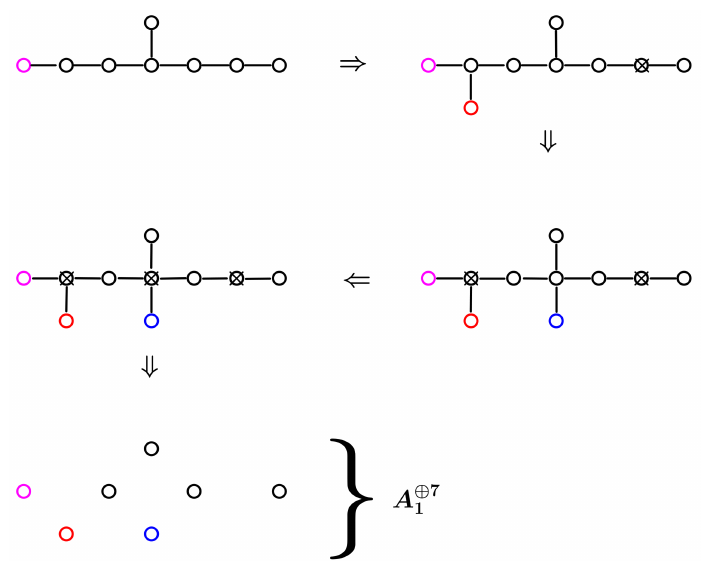
Figure 12 . Maximal subalgebra in the N = 7